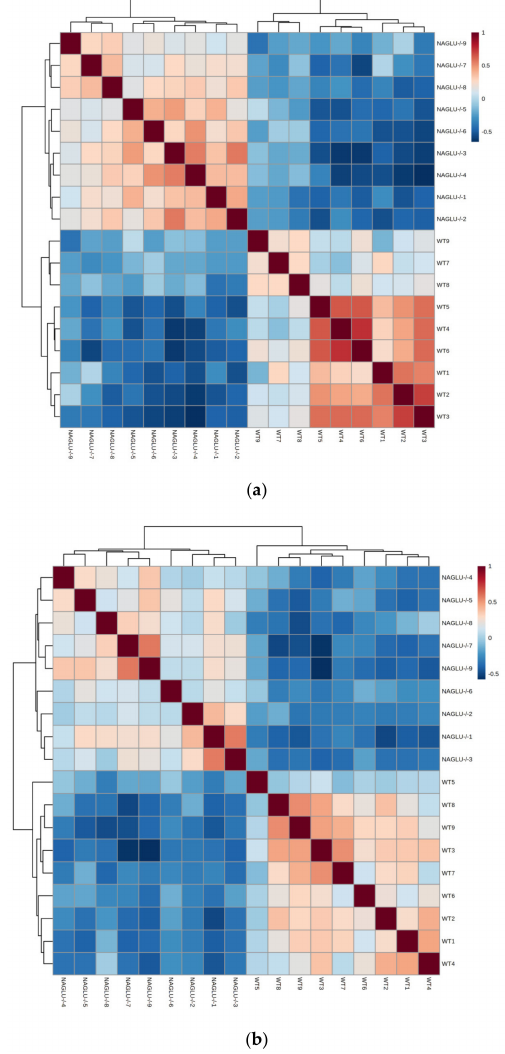
Figure 1. Correlogram of intra- and inter-groups (NAGLU − / − and WT) from heart ( a ) and liver ( b ) tissues. The concentrations of the metabolites from NAGLU − / − and WT heart and liver were normalized according to protein tissue contents, log(2) transformed, Pareto scaled, and analyzed using Spearman’s rank correlation analysis with MetaboAnalyst 4.0 software. The red and blue colors of the cells in the heatmaps indicate positive and negative correlation, respectively. Abbreviations: NAGLU, α - n -acetylglucosaminidase; WT, wild